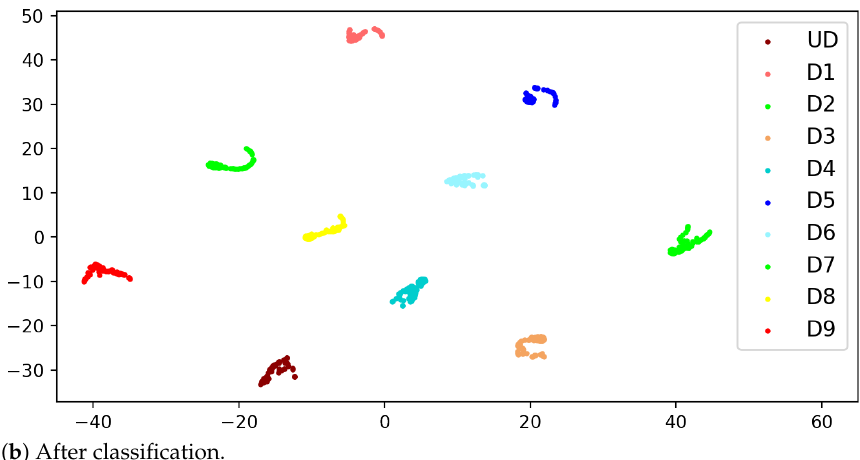
Figure 7. Visualization results of the test samples before and after